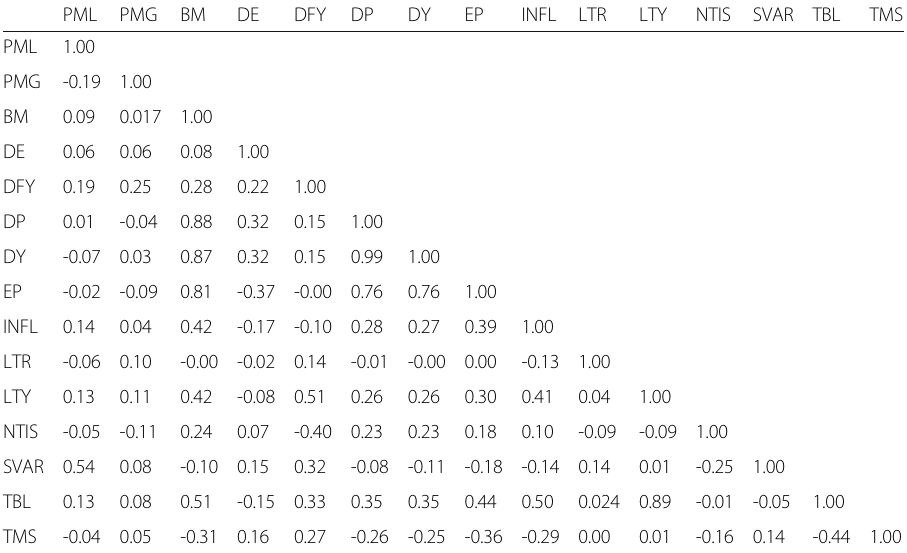
Table 10 Correlation Matrix. Monthly